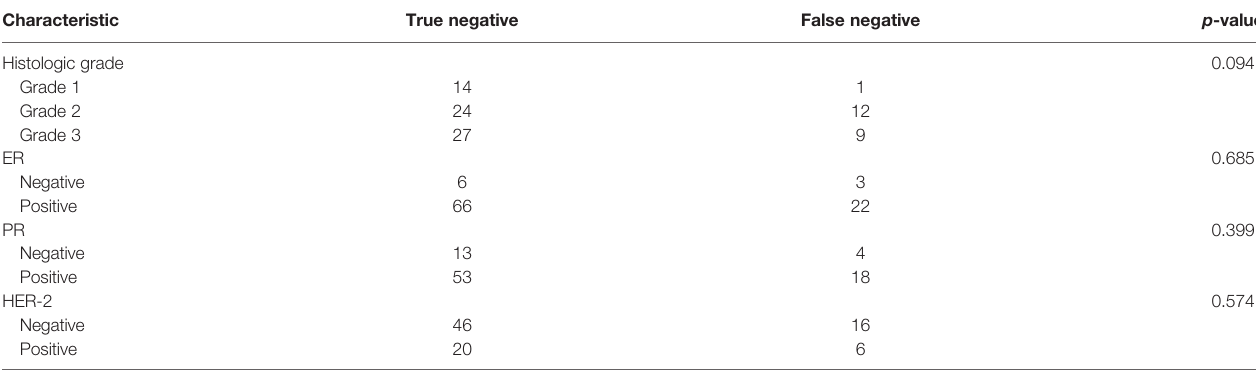
ER, estrogen receptor; PR, progesterone